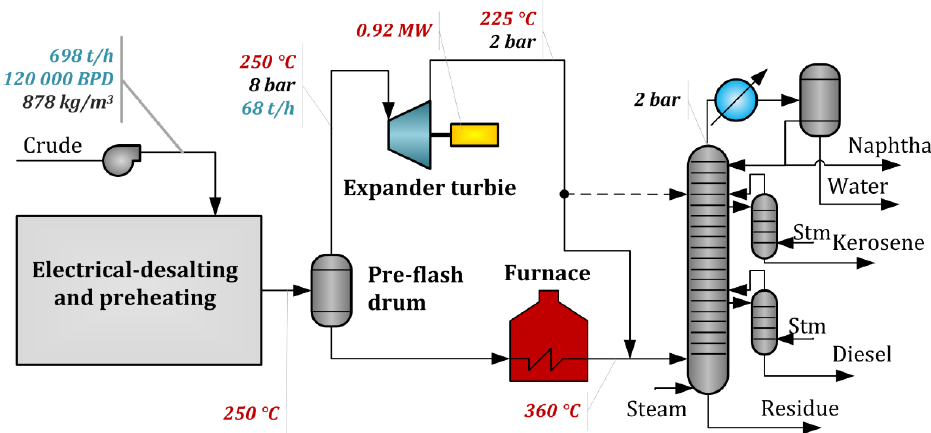
Figure 9. Crude distillation unit integrated with a turboexpander.